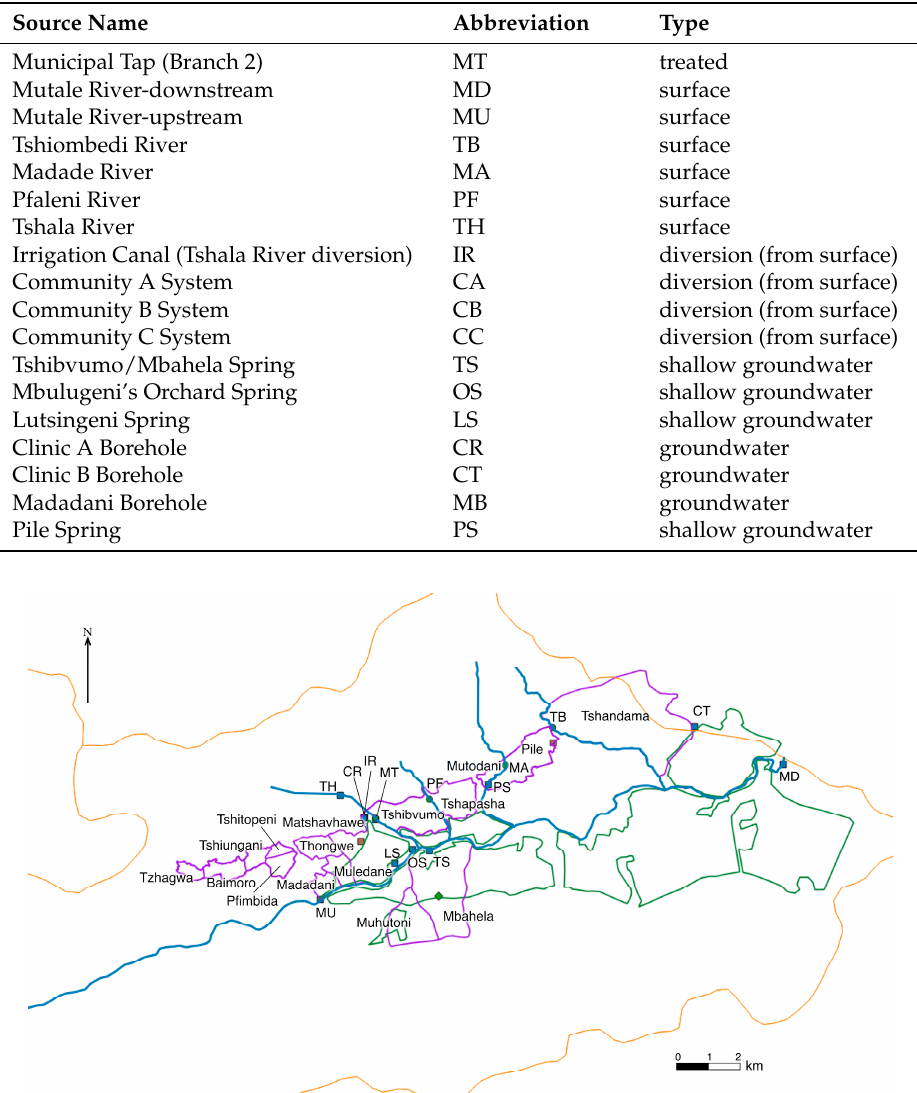
Table 1. Abbreviations, water sources and type.